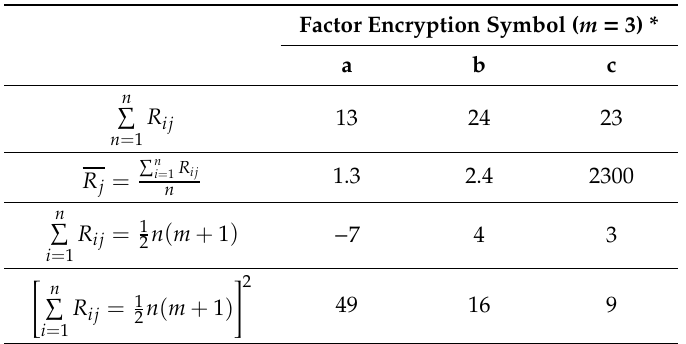
Table 3. Table of received evaluation